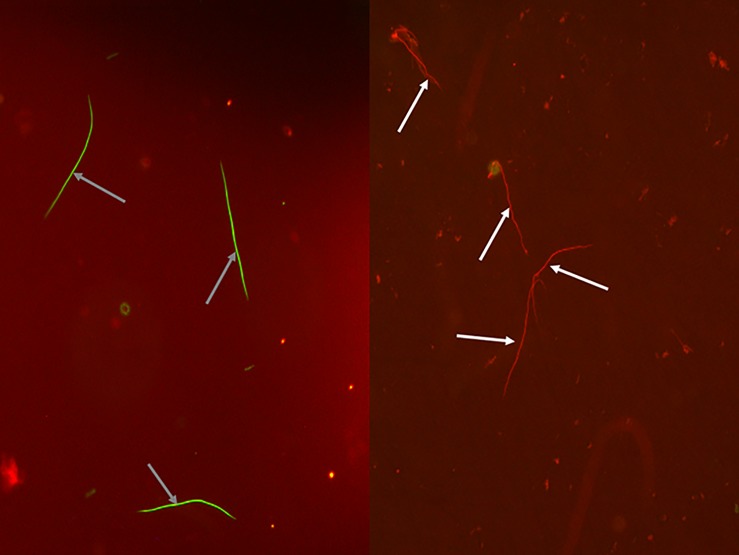
Assay of sperm cell viability.Live sperm cells are stained in green (indicated by grey arrows), dead sperm cells are stained in red (indicated by white arrows).